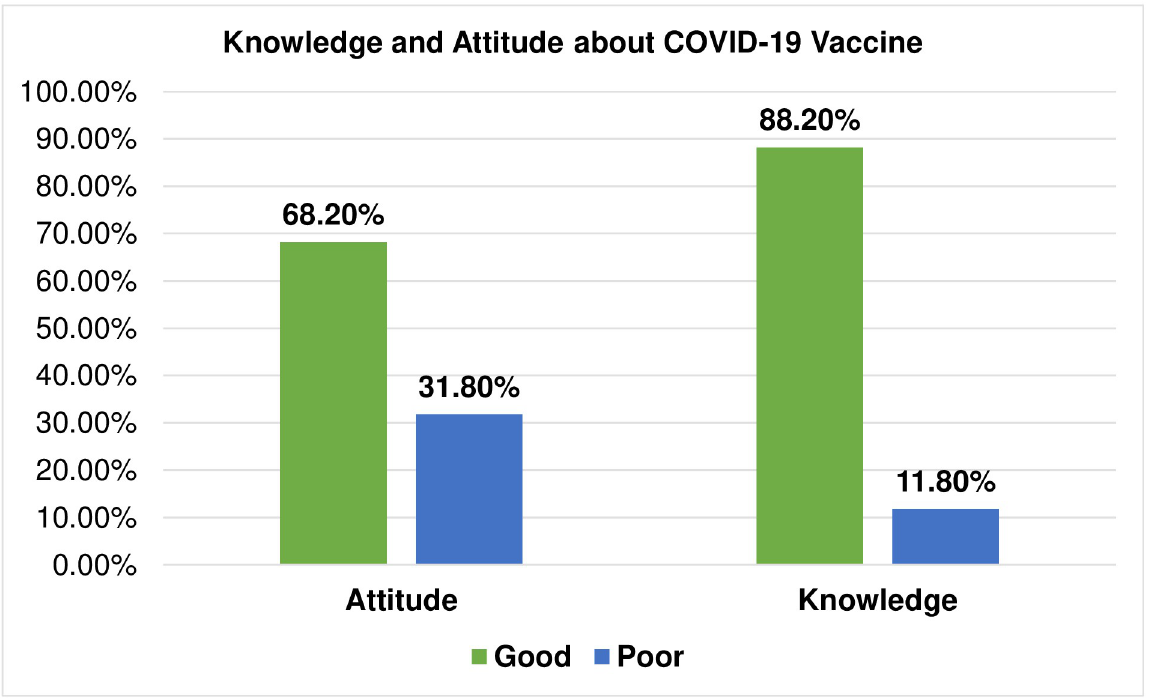
Fig 3. Participants’ knowledge and attitude about COVID-19 vaccine among pregnant woman attending antenatal care clinic at Gondar town, Northwest Ethiopia, 2021 (n = 510).